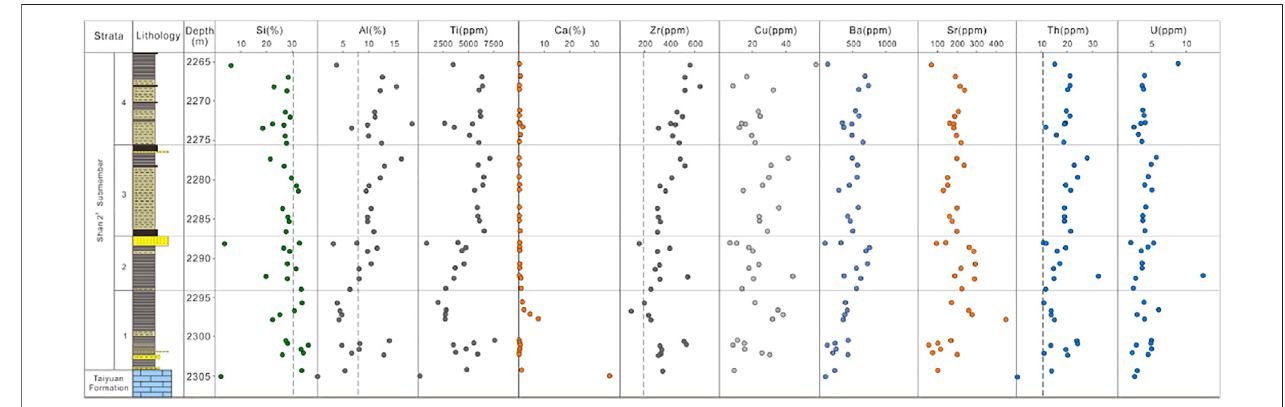
FIGURE 5 | Major and trace elements ’ concentrations for Shanxi Formation Shan 2 3 Submember shale from the studied well in the Eastern Ordos Basin. Dashed lines represent the upper continental crust value for each element (McLennan,